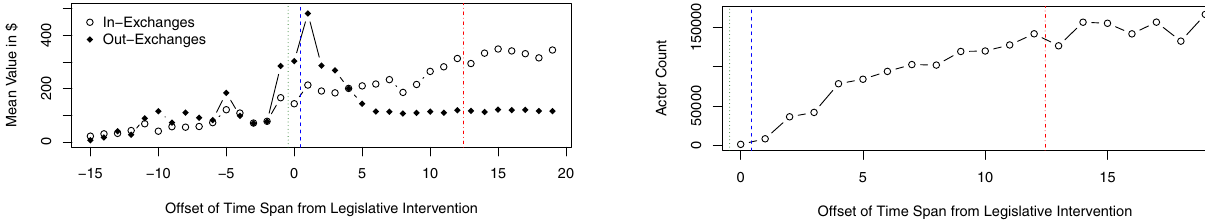
Fig. 13 Number of actors engaged in incentives. Temporal representation of the number of actors engaged in tax-incentives, after span 0. The number of actors reaches 164,441 accounts per span.